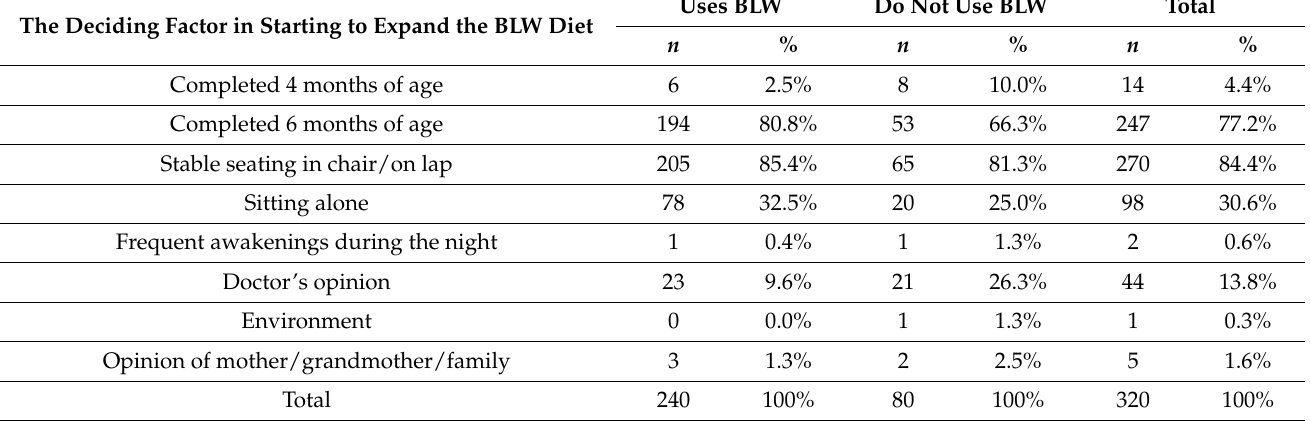
Table 5. Factors determining the start of dietary expansion with the BLW method among the surveyed mothers—multiple choice